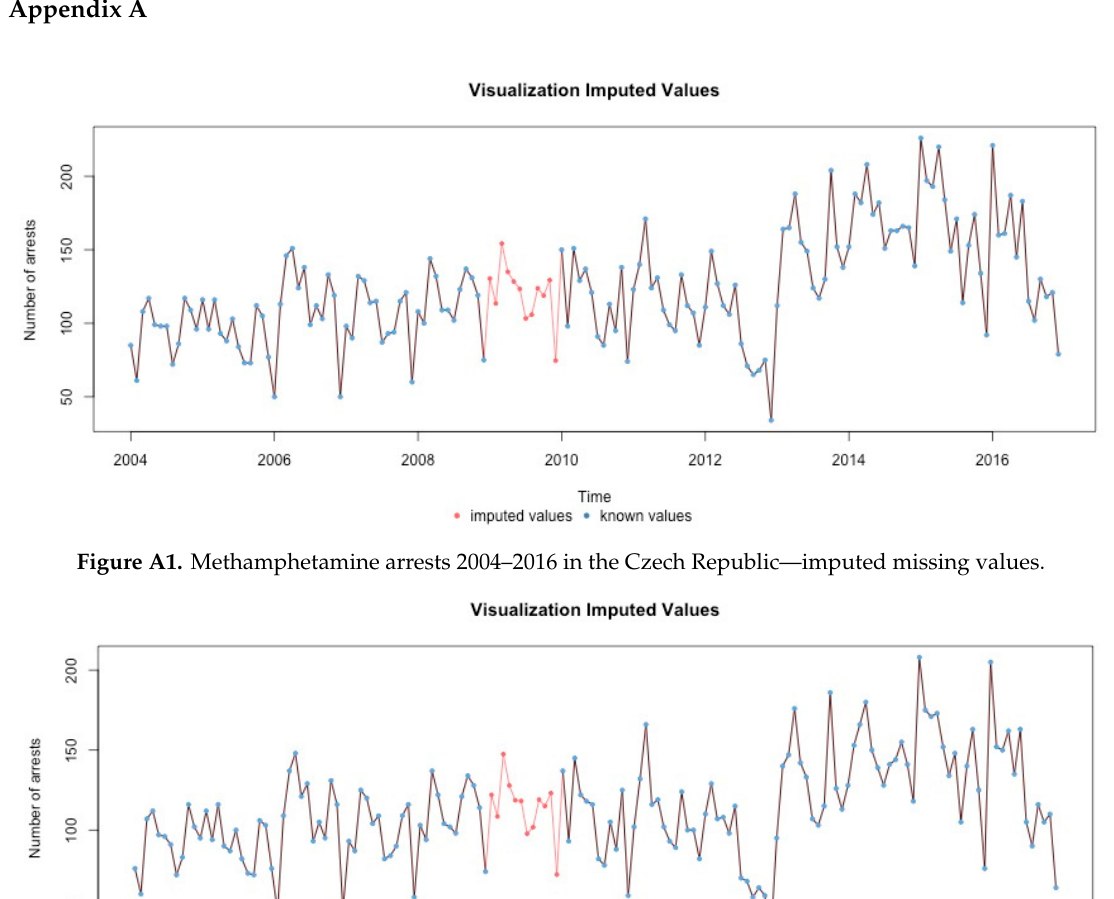
Figure A3. Methamphetamine foreign nationals arrests 2004–2016 in the Czech Republic – imputed missing values.